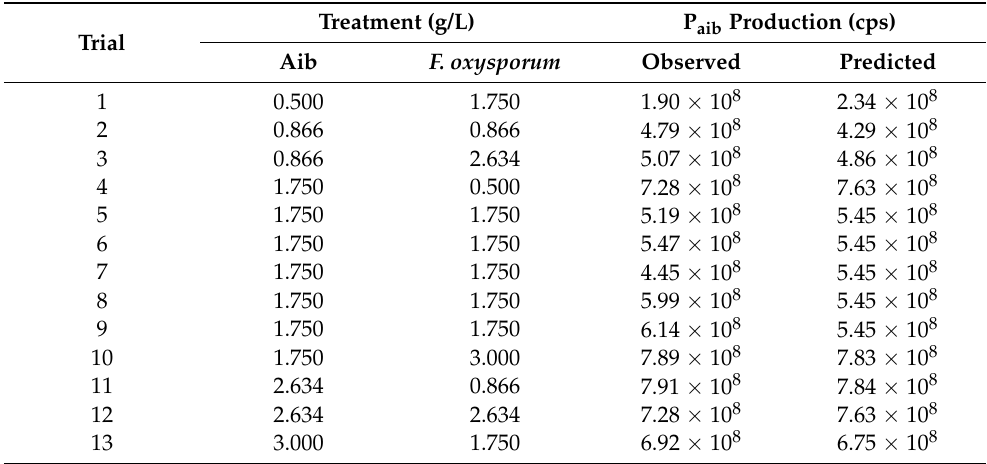
Table 3. Observed and predicted values for P aib production for each experiment of the central composite model that evaluates the concentrations of Aib and F. oxysporum .